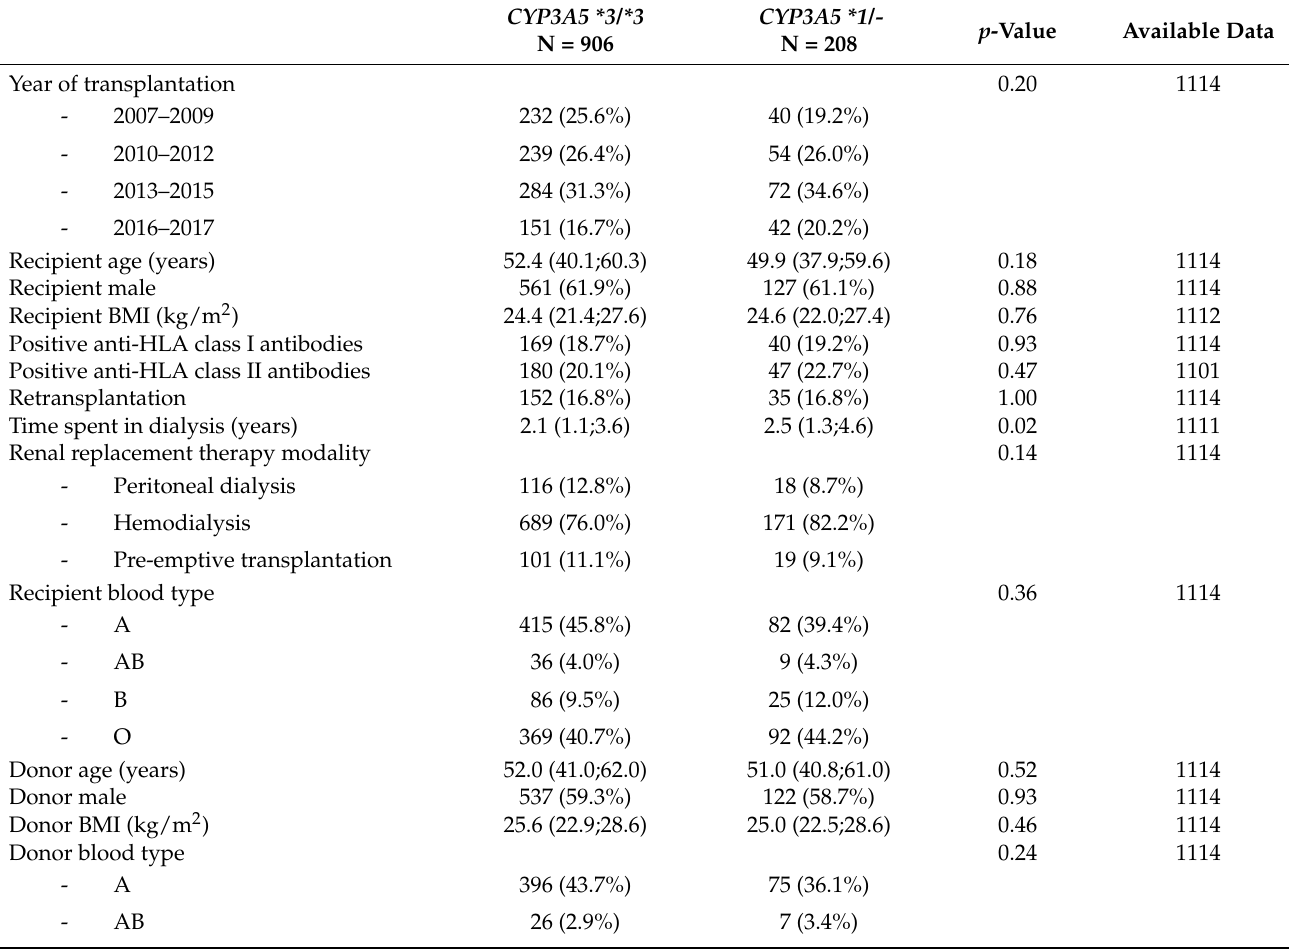
Table 1. Recipient and donor characteristics according to CYP3A5 genotype (n =